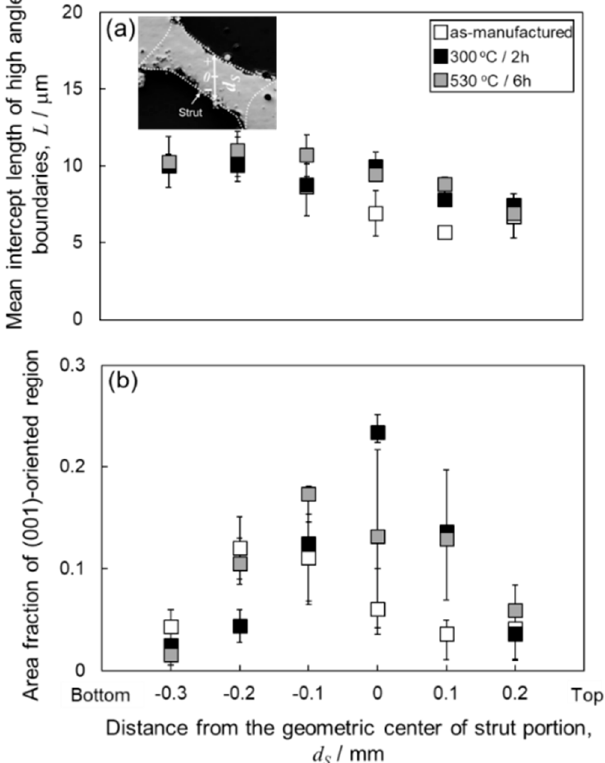
Figure 14. Changes in ( a ) mean intercept length of high-angle boundaries and ( b ) area fraction of the (001)-oriented grains plotted with vertical distance from the geometric center ( d S ) of the strut portion of the lattice specimen with heat treatment.